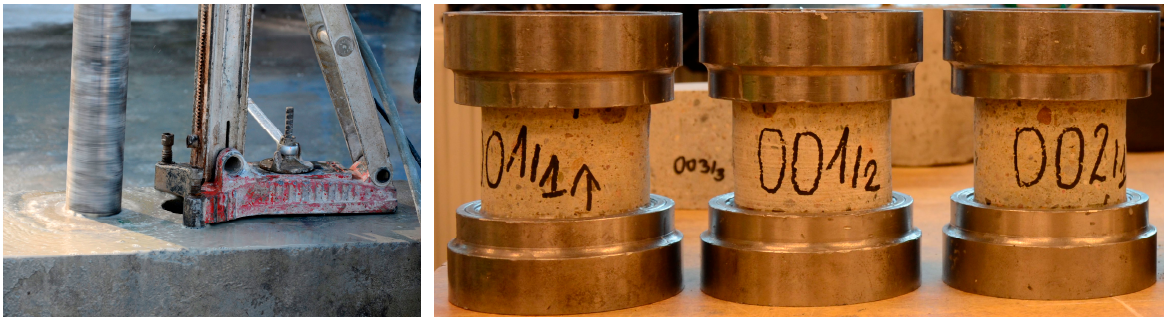
Figure 12. Testing for strength: core drilling and concrete specimens prepared for testing. Table 1. Results of compression tests on samples obtained from the foundation slab, subjected to cutting and grinding. Number of